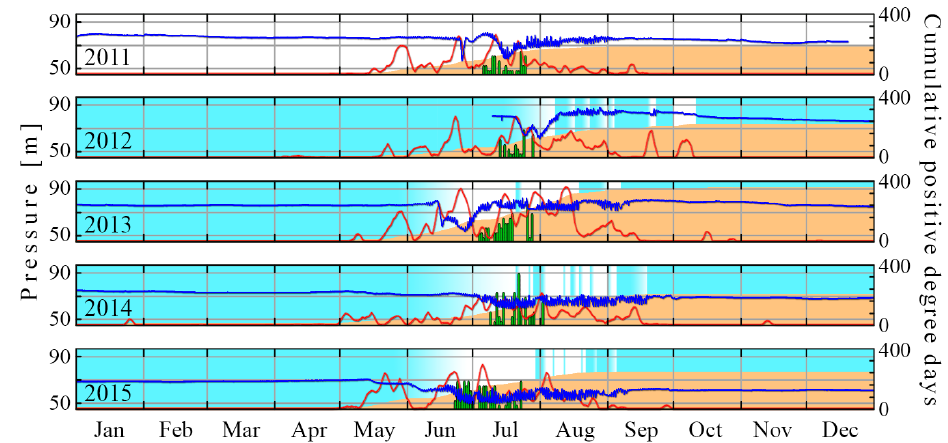
Figure 4. Pressure time series recorded in borehole D of Fig. 2 from 2011 to 2015 (blue line). Daily PDD values are shown as a red line, annual cumulative positive degree days as orange shading, and fresh snow cover determined from time lapse imagery as light blue shading. The fading blue at the end of the winter indicates the appearance of larger snow-free patches and the filling of a perennial supraglacial pond in the study area, rather than the complete disappearance of the winter snowpack. Green bars indicate the count of boreholes drilled each day on a scale from 0 to